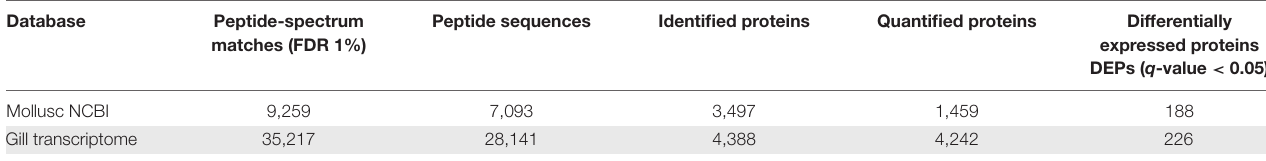
TABLE 1 | Protein identification and determined DEPs using the transcriptome database and the mollusc NCBI nr protein database.